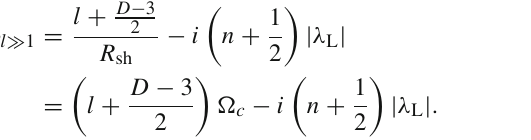
Bysubstitutingthemetricfunctionofthehigh-dimensional Schwarzschild STVG black hole, Eq. (12), into Eqs. (24) and (25), we can obtain the angular velocity (cid:9) c and the Lya- punov exponent λ L . Then we can plot the graph of the angular velocity (cid:9) c and the Lyapunov exponent λ L with respect to parameter α as shown in Fig. 4. We find from this figure that the increase of parameter α makes the angular velocity λ (cid:9) c and the Lyapunov exponent L monotonically decrease in spacetime dimension D = 4 , 5 , 6 , 7, which means the increase of parameter α makes real parts of quasinormal fre- quencies in the eikonal limit and negative imaginary parts monotonically decrease. However, the increase of spacetime dimension makes the angular velocity (cid:9) c and the Lyapunov exponent λ L monotonically increase for a fixed α when the cases of D = 5 , 6 , 7 are compared with the case of D = 4,